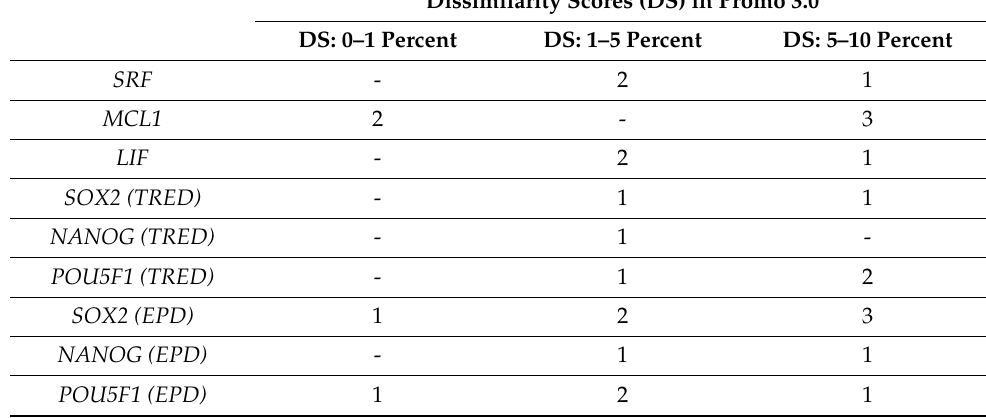
Table 2. Number of ets motifs predicted on selected promoters and their dissimilarity score (DS) range; DS of 0% means perfect match to consensus; TRED, Transcriptional Regulatory Element Database; EPD, Eukaryotic Promoter Database. * Number of Predicted ets Binding Motifs with Different Dissimilarity Scores (DS) in Promo